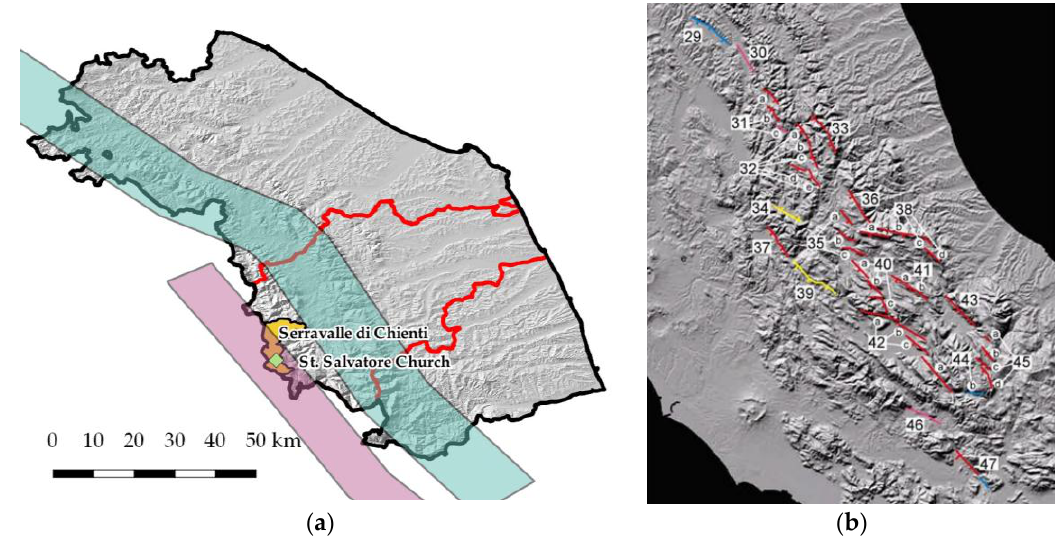
Figure 3. ( a ) The map shows the Marche region (black line), with Macerata province highlighted (red line) and Serravalle di Chienti municipality (yellow area). The church is identified with a green square; two stripes represent the major seismogenic faults that cross the territory, Colfiorito-Campotosto fault (purple stripe) and Vettore-Porche-Bove (light blue stripe). Source data: [41]. ( b ) The map shows the principal active faults of the Central Apennine Mountain chain: Gubbio (29), Gualdo Tadino (30), Colfiorito (31), Norcia (32), Mt.Vettore (33), Leonessa (34), Alta Valle dell’Aterno (35), Mt. Della Laga (36), Rieti (37), Campo Imperatore-Assergi-Mt. Cappucciata (38), Valle del Salto (39), Campo Felice-Colle Cerasito/Ovindoli-Pezza (40), Media Valle dell’Aterno (41), Fucino (42), Mt. Morrone (43), Alta Valle del Sangro (44), Aremogna-Cinquemiglia (45), Sora (46), St. Pietro Infine (47) [42] (p. 10).